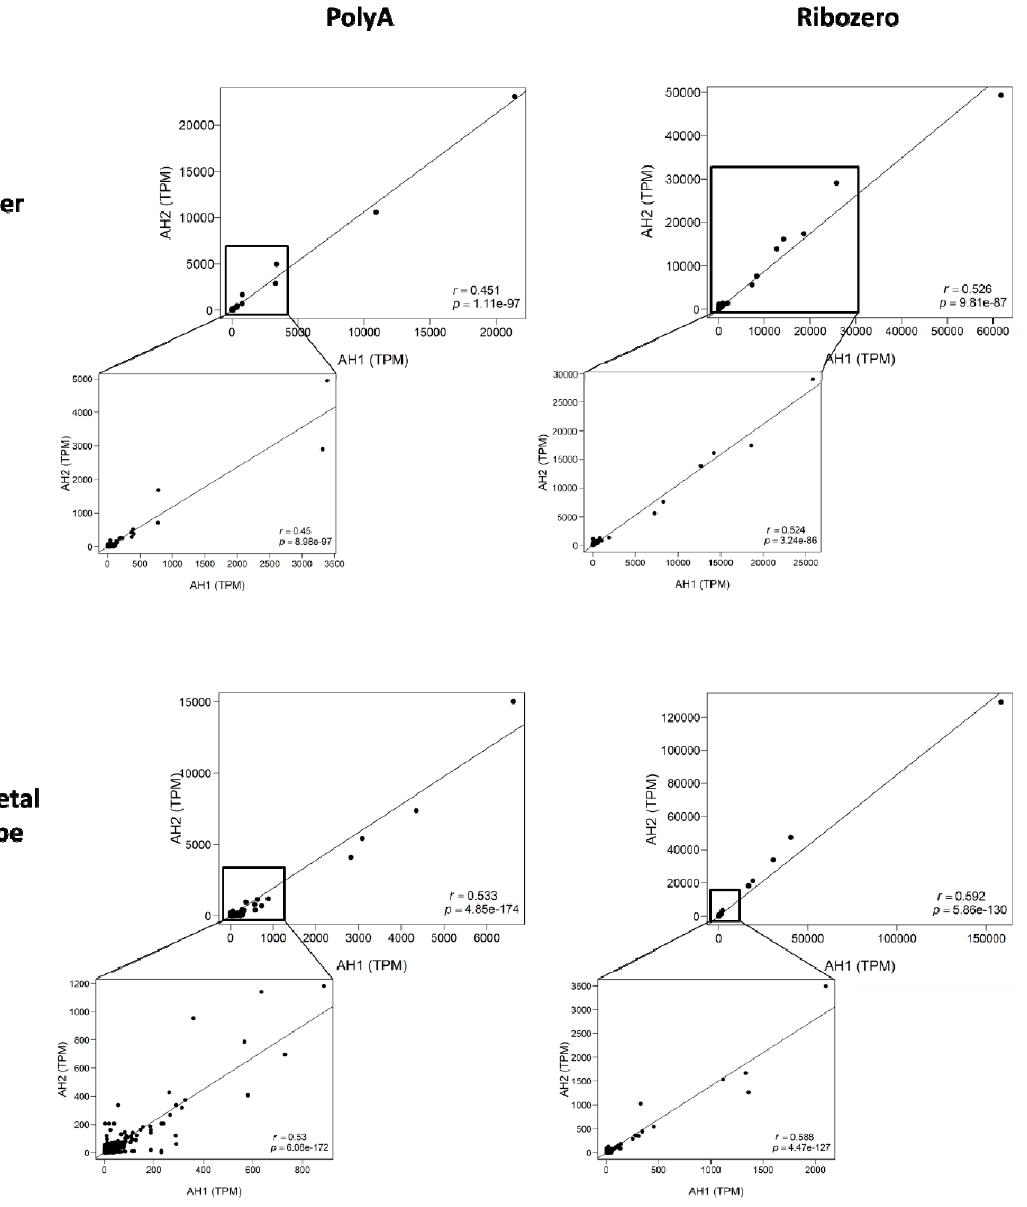
Figure 2. Correlation plots for lncRNA expression between biologic replicates. The poly-A + selected libraries are on the left, the rRNA depleted libraries on the right. The top two graphs are from the liver while the bottom two are from the parietal lobe of the cerebrum. The x-axis indicates expression of the individual lncRNA in adult horse 1 (AH1). The y-axis shows expression of the same lncRNAs in adult horse 2 (AH2). Spearman correlation (r) and p -value in bottom right corner.